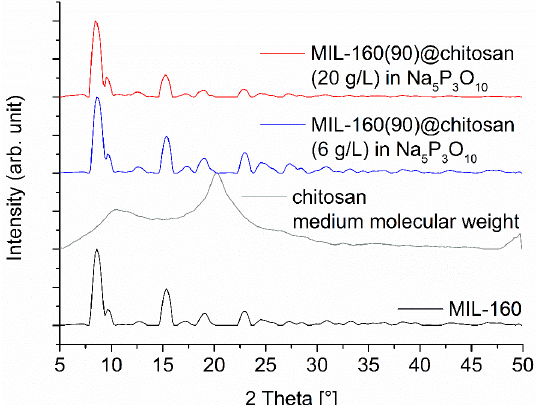
Figure 7. PXRD patterns of MIL-160(90)@chitosan composites for a MOF content of 90 wt-%, prepared with different chitosan concentrations. The diffraction patterns for 60 and 80 wt-% MIL-160@chitosan are shown in Figure S6 (Supplementary Information). The broad contribution from amorphous chitosan is only seen at lower MOF wt-% (Figure S6). The broadening of the PXRDs are related to the short measurement time of 6 min on the Bruker D2 phaser, which was used due to the large number of samples and is not related to a low crystallinity of the MOF (cf. Figure S4 in the Supplementary Information with the sharper reflexes measured on a Rigaku Miniflex).